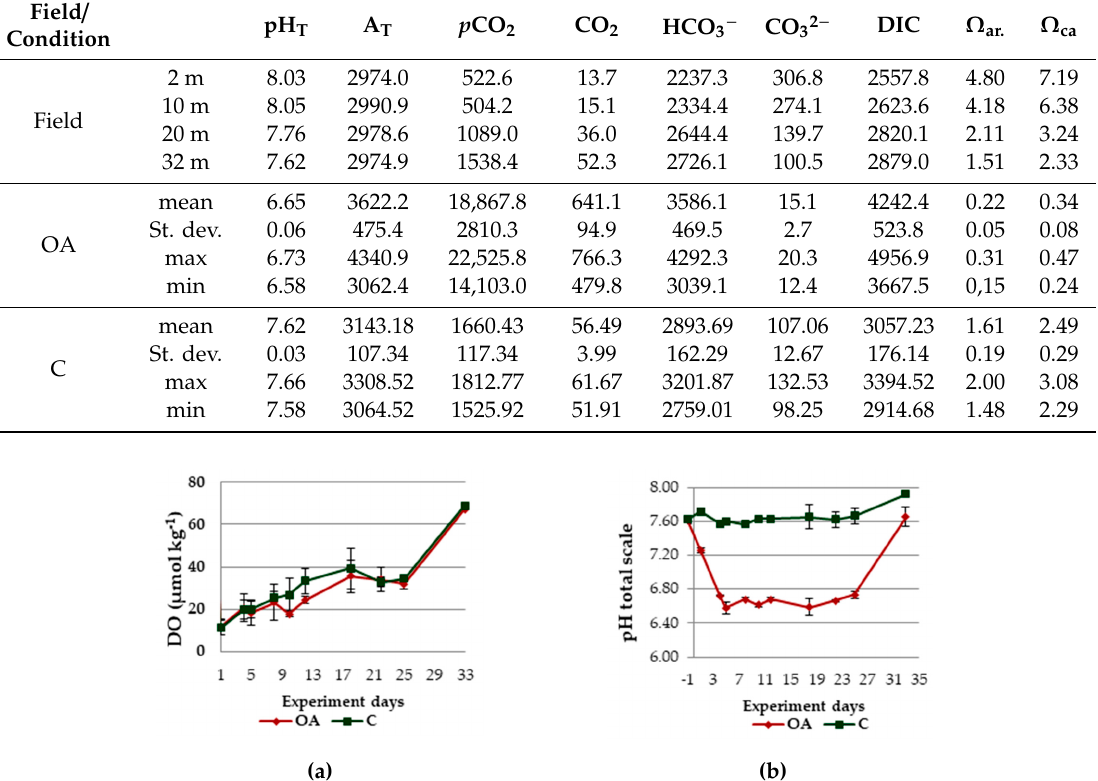
Figure 5. DO concentrations (in μ mol kg − 1 ; a ) and pH T ( b ) for the duration of the experiment;